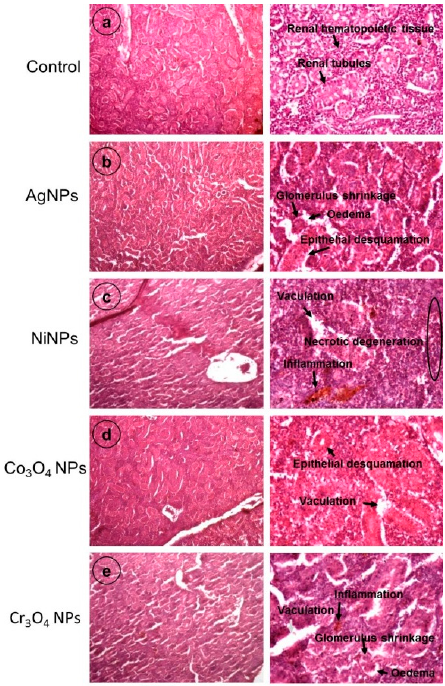
Figure 10. Histological evaluation of kidney of control and NP-treated fish groups demonstrating the alterations appeared in different parts caused by NPs exposure. Images are taken at two different magnifications: 10× (left panel); 40× (right panel).